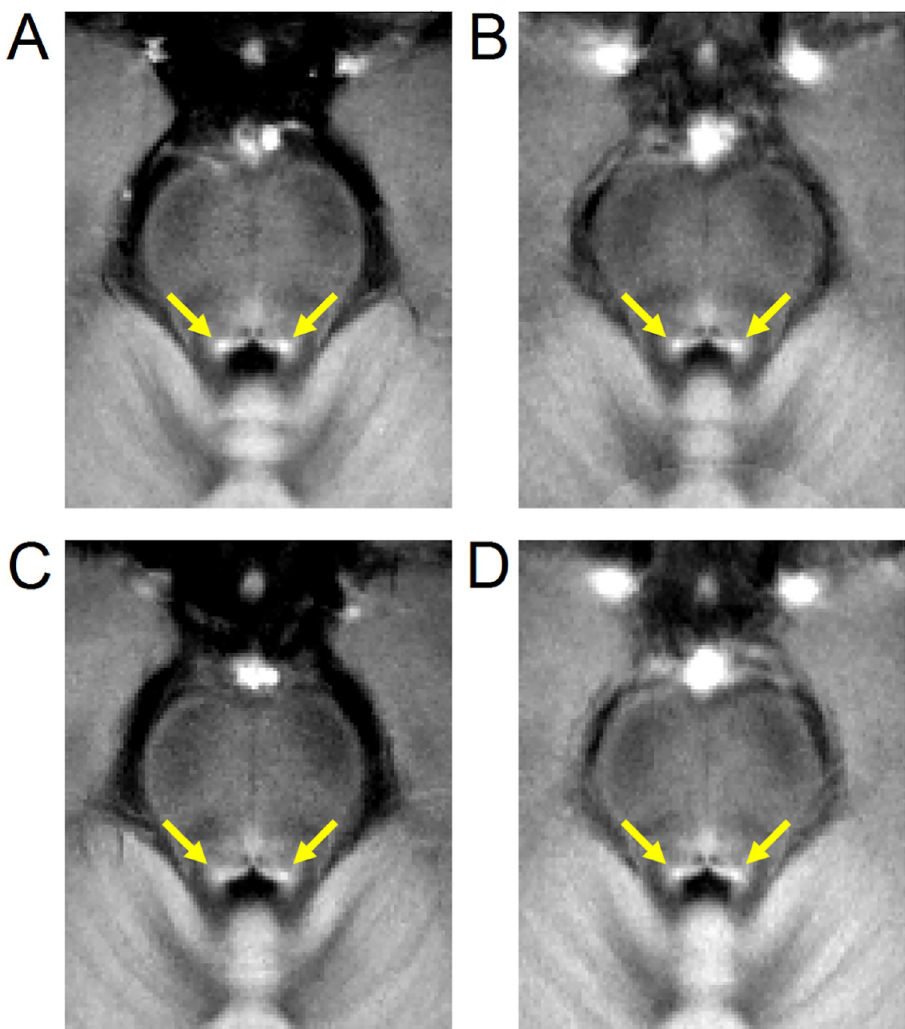
Fig 2. A comparison of mean LC contrast in control (top row) and PD (bottom row) groups for both cohorts. Mean MTC images from cohort 1 are shown in the left column while mean MTC images from cohort 2 are shown in the right column. For each group, the mean MTC image was created by transforming MTC images from individual participants to MNI space and then averaging. In each image, yellow arrows indicate the location of